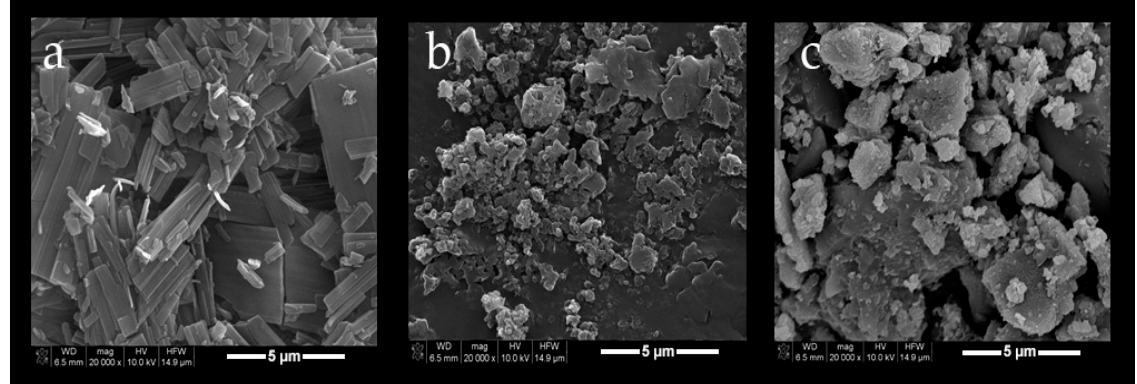
Figure 4. Scanning electron microscopy (SEM) photomicrographs of PCX ( a ); PCX:6OCapro β CD inclusion complex ( b ) and PCX:PC β CDC6 inclusion complex ( c ).